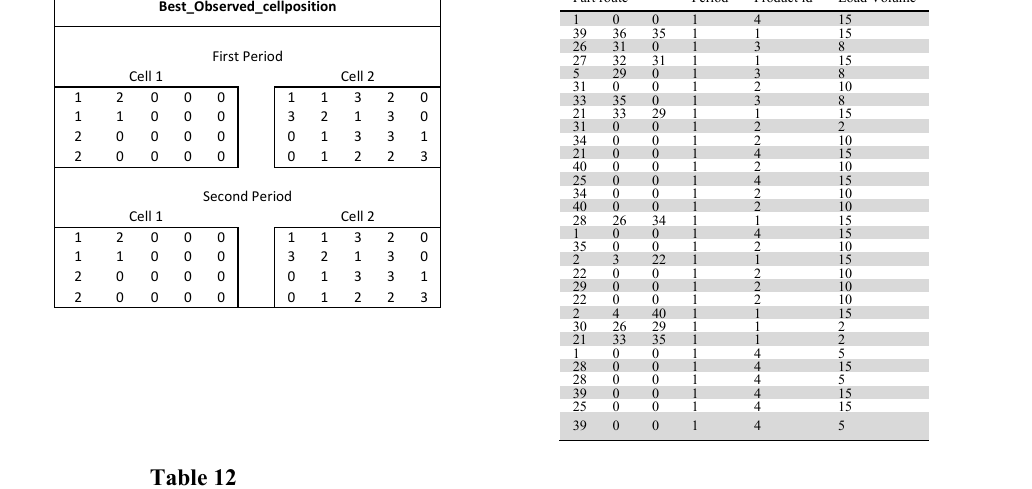
The best observed machine loads